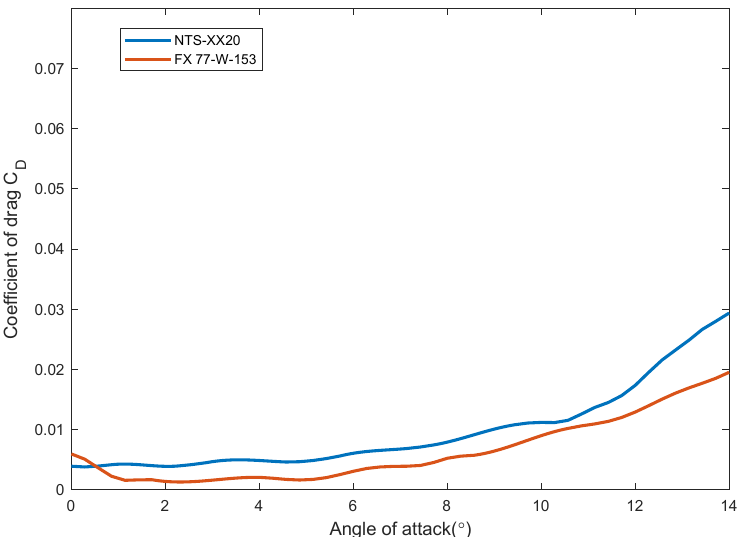
Figure 7. Variation of the coefficient of drag for NTS-XX20 compared with that of FX77-W-153 at different AOA and Re = 2 × 106.